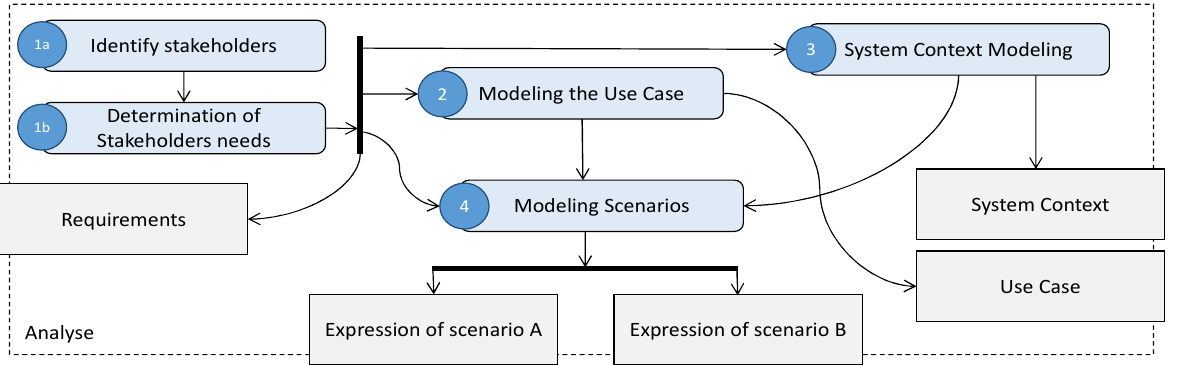
Figure 2. Methodology for modeling future scenarios.